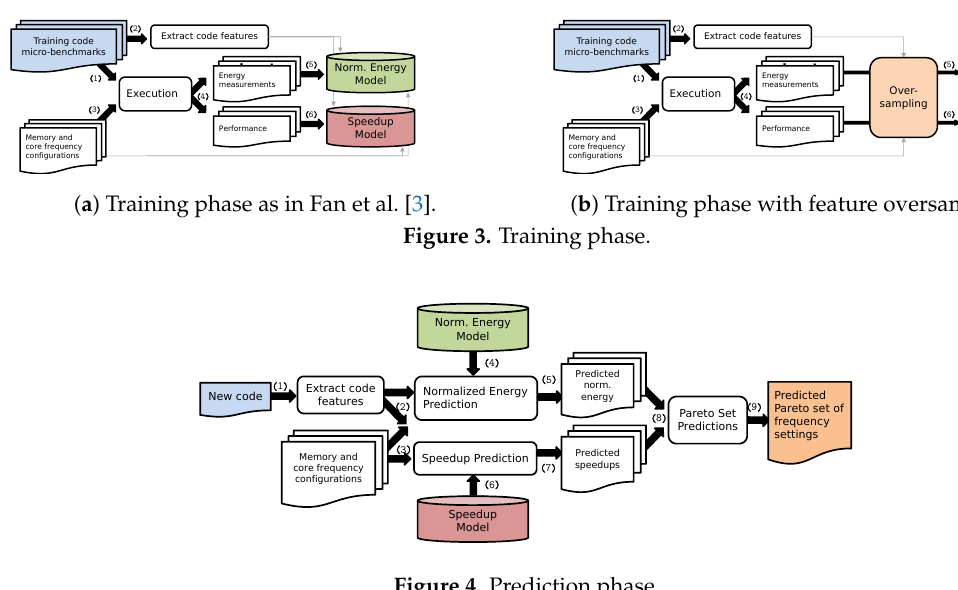
Figure 4. Prediction